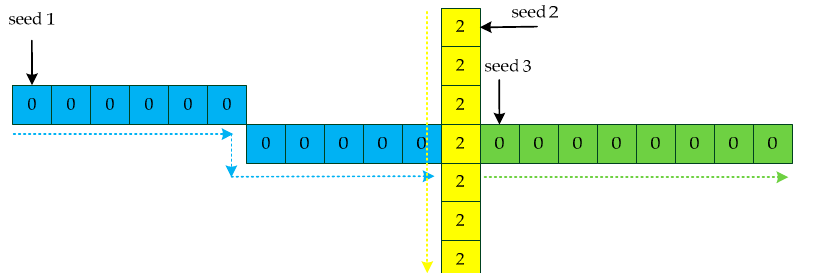
Figure 15. Line searching method based on slopes. Determine the seed point according to the judgment condition, and then find the line according to the slope of the nearest neighbor point until traversing all the points. When all the lines are categorized, we need to set thresholds to eliminate non-line points. Due to our conditions applied to individual points and short line segments, lines containing fewer points are removed. Since the same line is divided into sections by noise, we propose a method to solve this problem. As shown in Figure 16, for two endpoints p j 1 , p j 2 of each line, two lines are the same line only if the distance of two endpoints is less than the threshold and the two lines have the same slope. For the line l i , we compare the line l 1 to the lines l 2 , l 3 , . . . , l n , then compare the line l 2 to the lines l 3 , l 4 , . . . , l n , until, finally, we compare the line l n − 1 to the line l n . When all lines have been identified, repeat the steps until the number of lines is changeless.